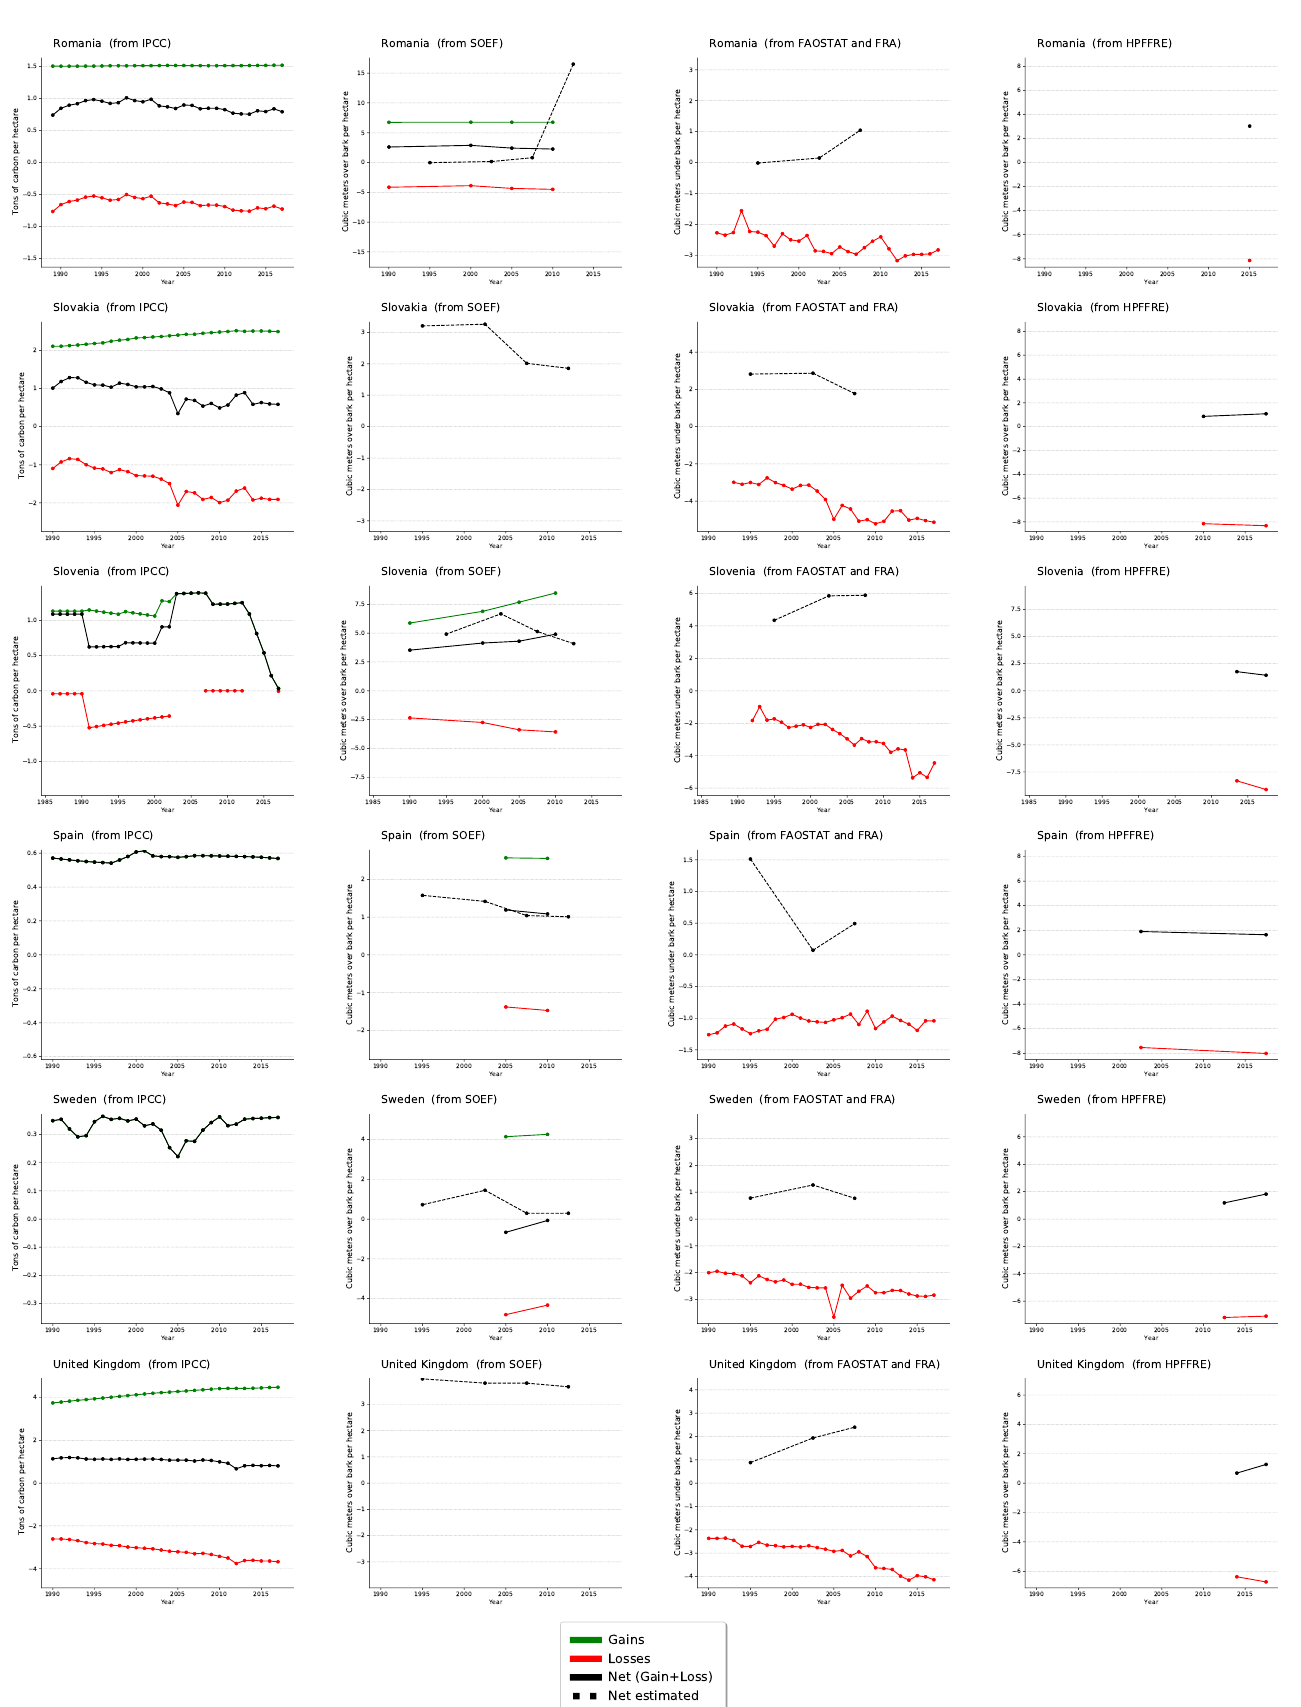
Figure A1. Comparison of the forest dynamics expressed in the original units for all